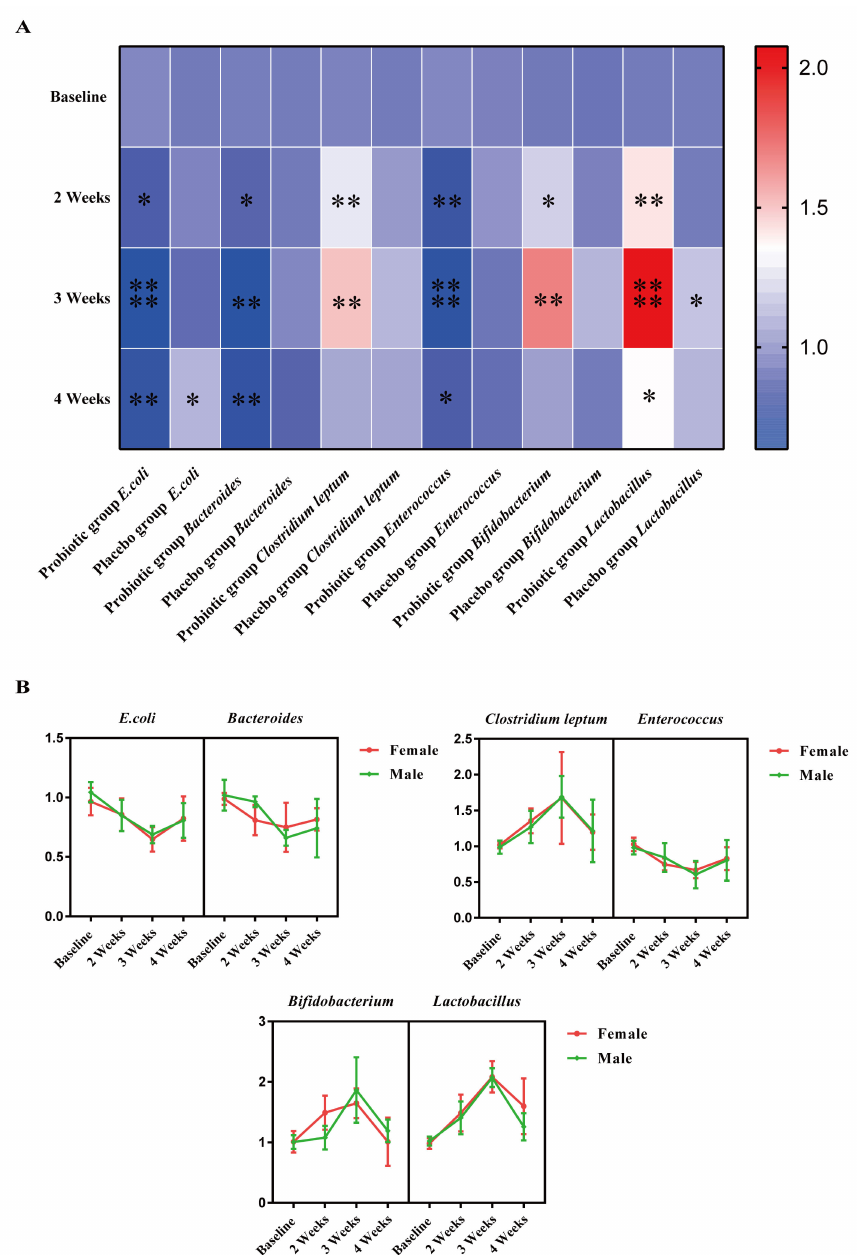
Figure 4. Relative expression of fecal flora in volunteers. ( A ) Relative expression levels of 6 species of bacteria in the feces of volunteers ( B ) Relative expression levels of 6 species of bacteria in the feces of volunteers in the probiotics group. Colors ranging from blue to red indicate low to high expression. Asterisks indicate significant differences (paired t -test, compared with baseline value * p < 0.05, ** p < 0.01, **** p < 0.0001). n = 10 or n = 5 volunteers per